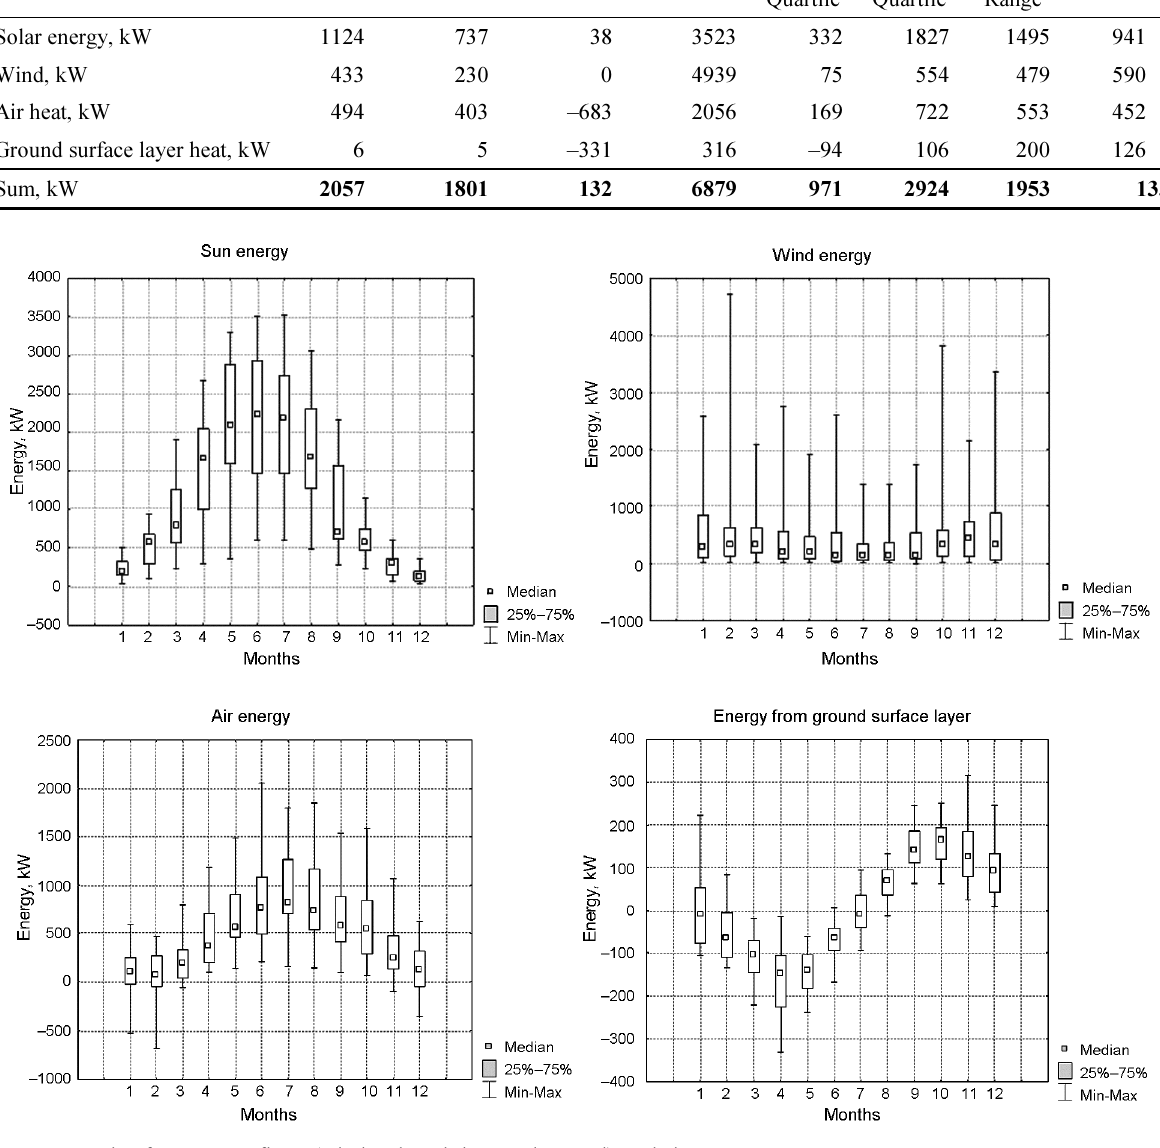
Fig. 7. Dynamic of RE energy flows (wind, solar, air heat and ground)